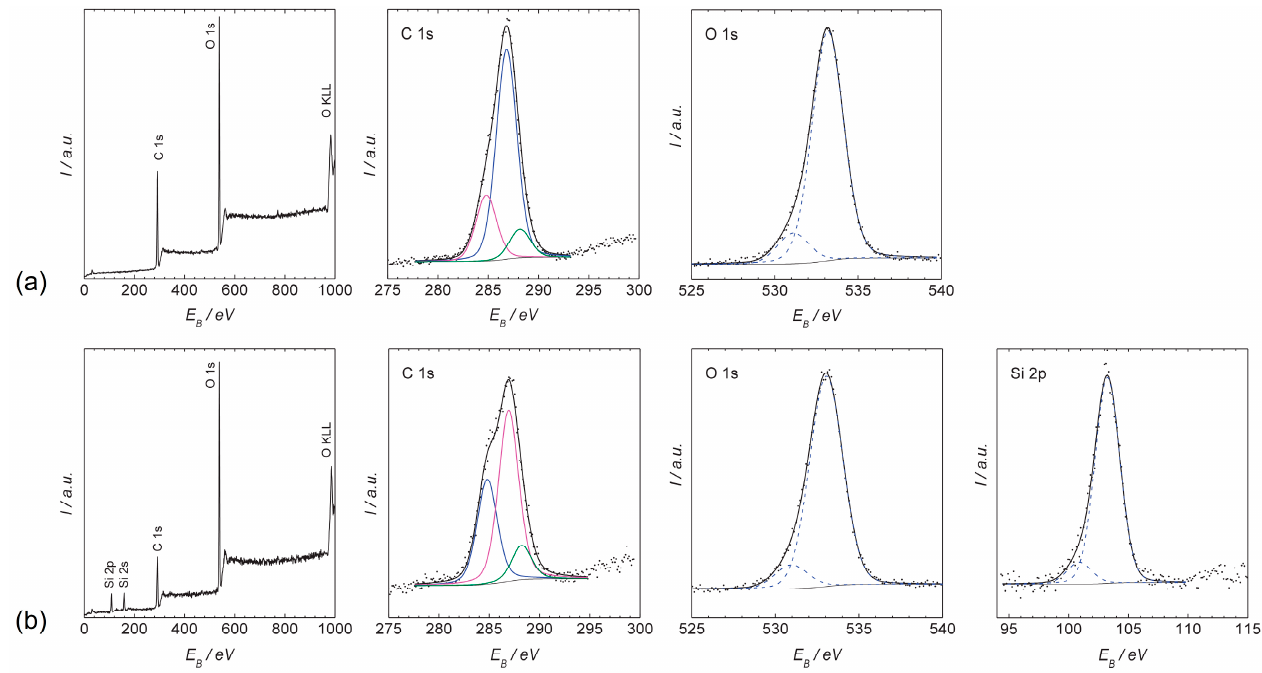
Figure 4. XPS spectra of the ( a ) zero sample and ( b ) functionalized cellulose.